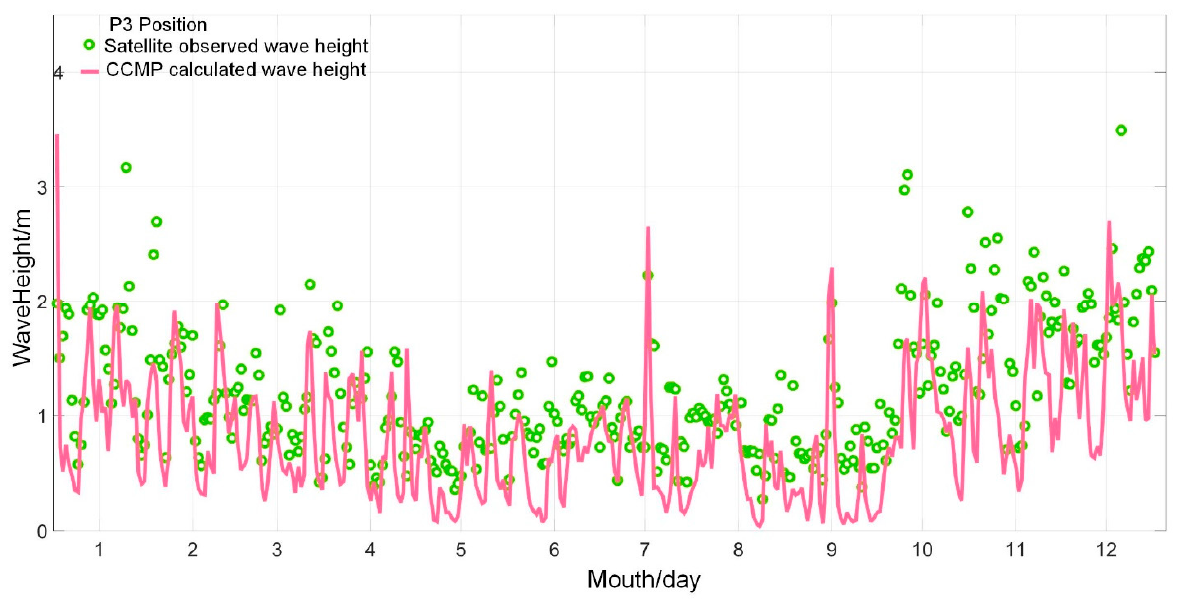
Figure 4. Observed and calculated wave height variation trend at the P3 position. The pink line represents the simulated wave height of the CCMP wind field, and the green dotted line represents the observed data of the altimeter.